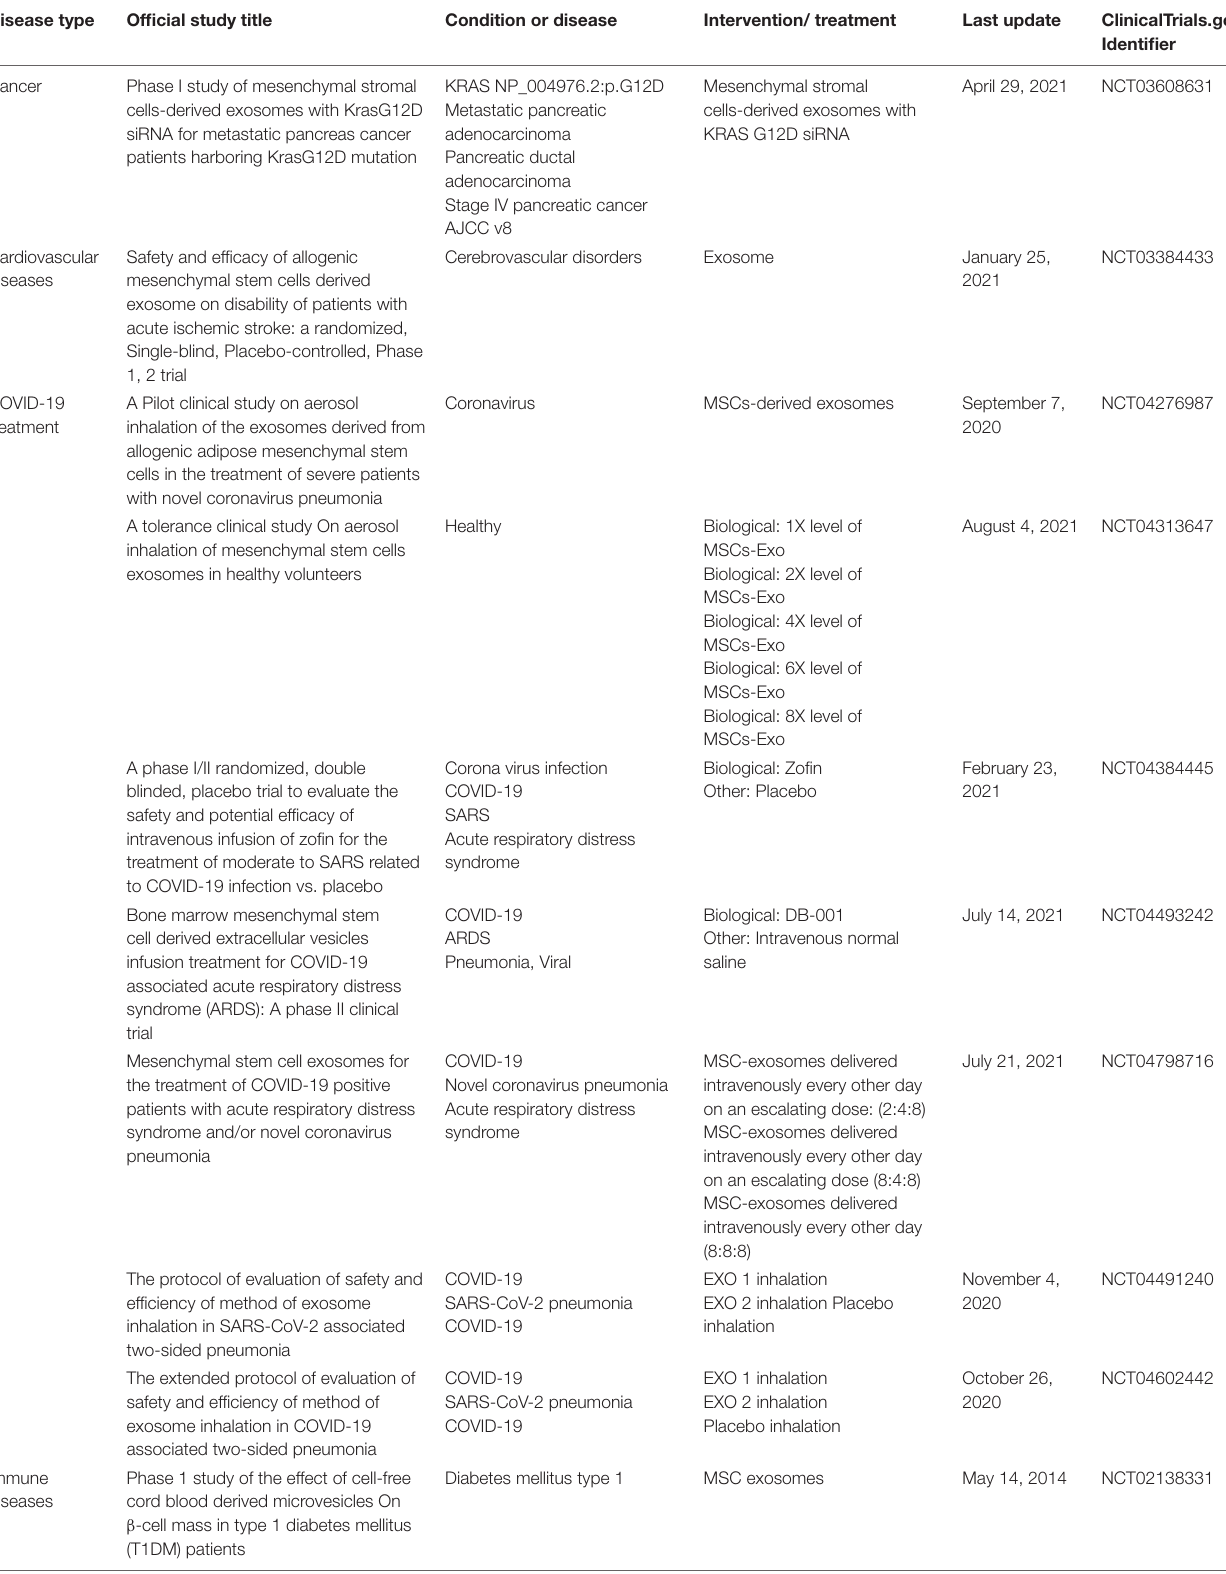
TABLE 4 | Some applications of MSCs-derived exosomes in recent clinical trials (U.S. National Library of Medicine clinicaltrials.gov, 2021). Disease type Last update ClinicalTrials.gov